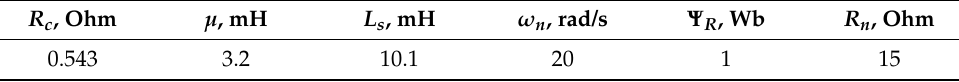
Figure 9. Mathematical model of a generator with a simplified design. Table 2. Generator parameters [40].